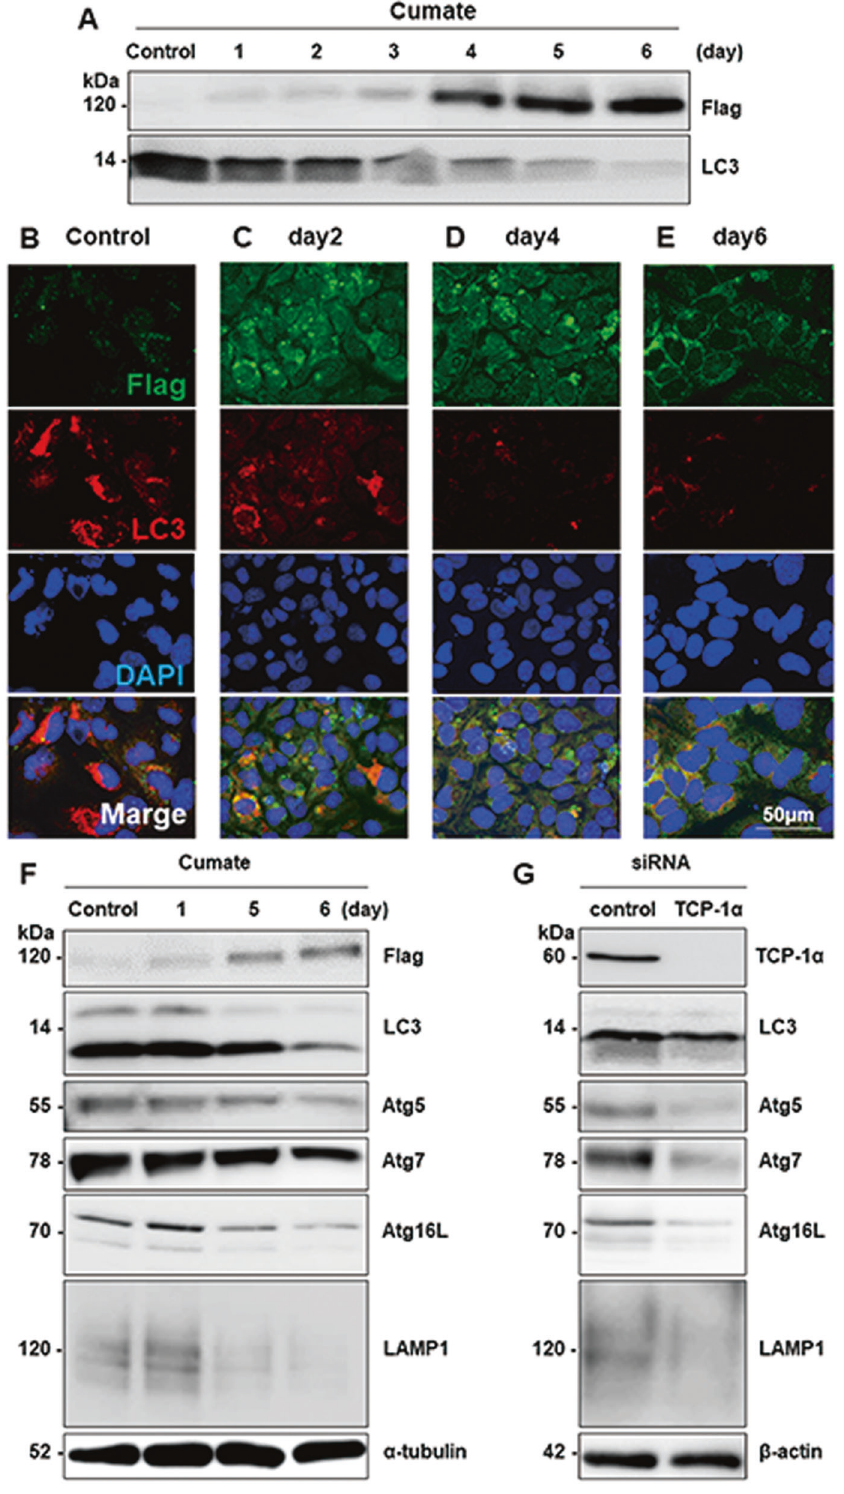
Fig. 6 In fl uence of persistent POTEF protein expression in HGrC1 cells. A Continuous culture of CuO-POTEF-Flag HGrC1 cells with cumate solution for 6 days. POTEF expression was detected persistently for 6 days and excessively after 4 days. LC3 expression decreased with persistent POTEF expression in CuO-POTEF-Flag HGrC1 cells. B – E Fluorescent staining of CuO-POTEF-Flag HGrC1 cells with anti-LC3 antibody with continuous POTEF expression. F With over-accumulation of POTEF in CuO-POTEF-Flag HGrC1 cells, levels of autophagy-related factors Atg5, Atg7, and Atg16L were slightly decreased. LAMP1, a lysosomal marker, was hardly detected with western blotting after 6 days. α -tubulin was used as the control. G Knockdown of TCP-1 α using siRNA in HGrC1 cells slightly decreased autophagy-related factors, except for LC3. Reduction in LAMP1 expression was remarkable. β -Actin was used as the